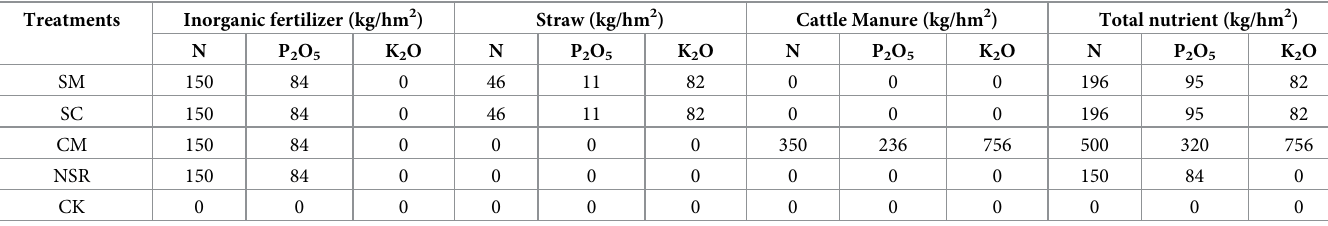
Table 1. Experimental treatments and